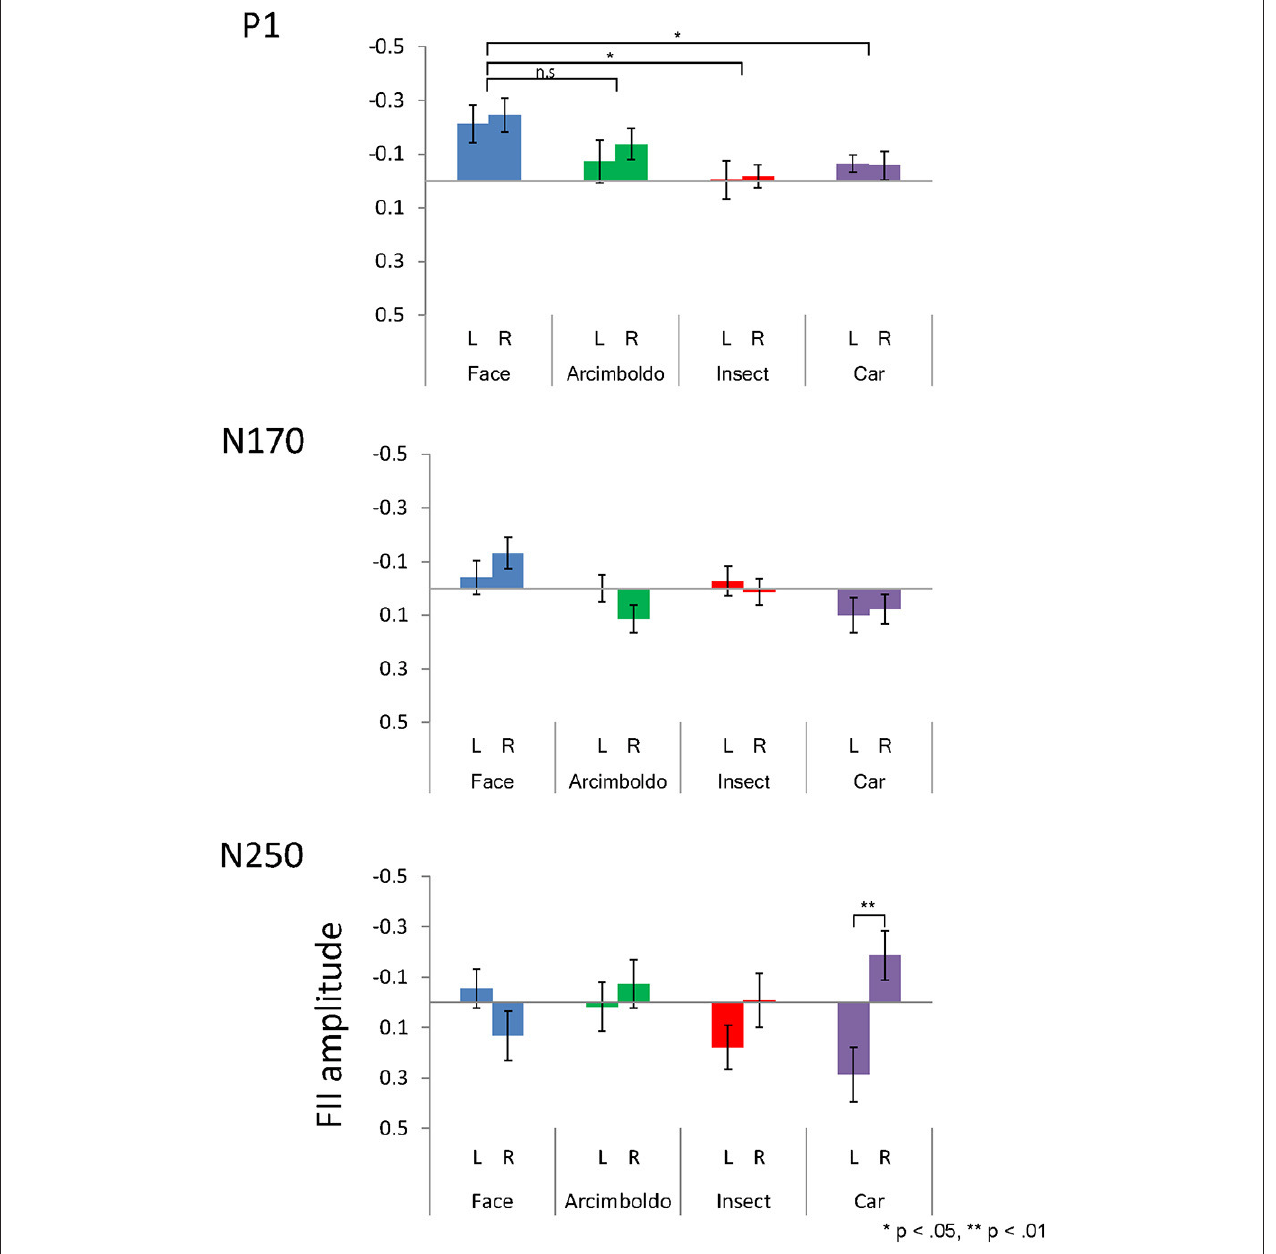
FIGURE 5 | The inversion effect index for peak amplitude of the P1 (Top) , N170 (Middle) , and N250 (Bottom) components, measured at the left and right pooled occipito-temporal electrode sites (averaged for electrodes P5/P9/PO7 and P6/P10/PO8) and displayed for 4 categories.